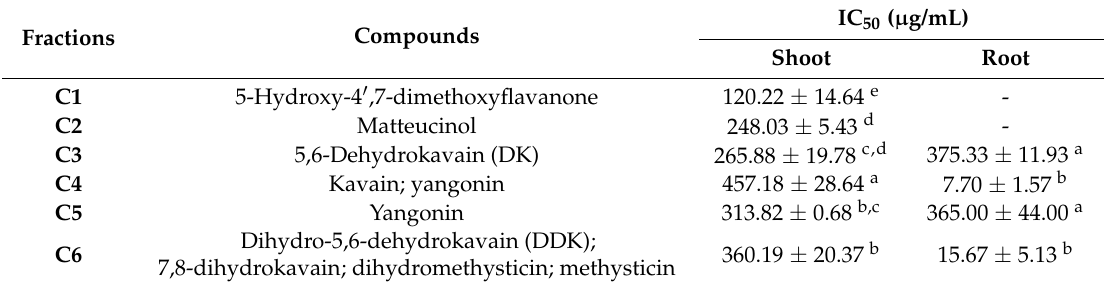
Table 6. Inhibitory activity of isolated compounds from P. methysticum root on growth of R. sativus (IC 50